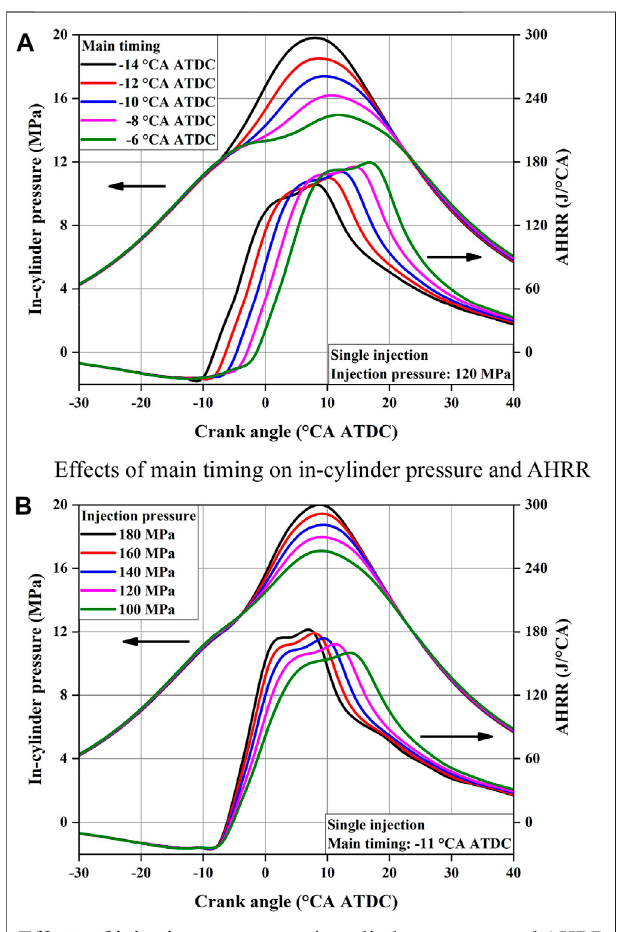
FIGURE 2 | Effects of single main injection timing and pressure on combustion characteristics. (A) Effects of main timing on in-cylinder pressure and AHRR, (B) Effects of injection pressure on in-cylinder pressure and